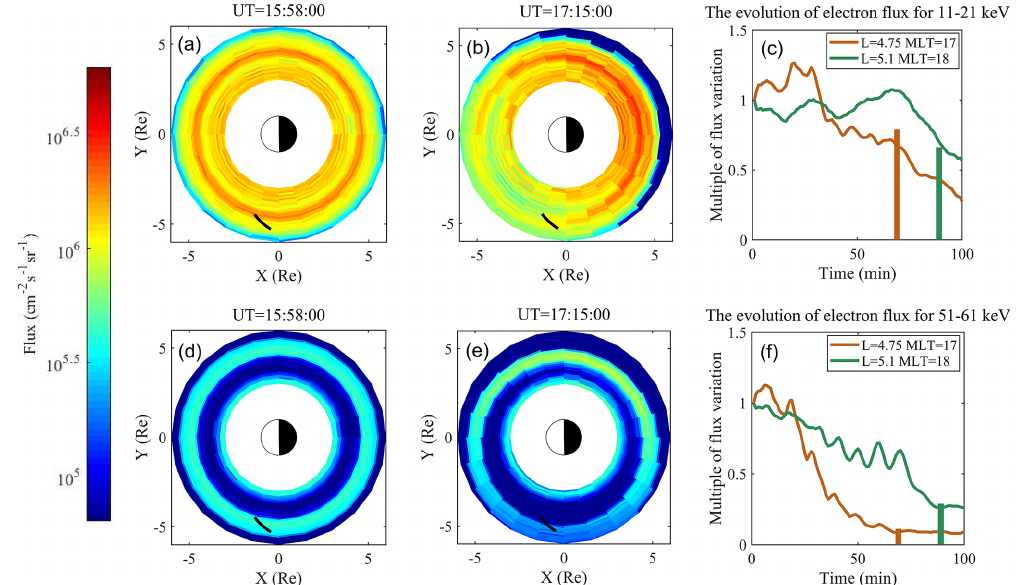
Figure 4. The comparison between the observed and simulated electron flux. (a) The simulation of electron flux distribution with energies from 11 to 21keV at 15:58UT. The trajectory of the Van Allen Probes is indicated by the solid black curve. (b) The evolved electron distribution with initial energies from 11 to 21keV at 17:15UT. (c) The normalized variations of electron fluxes with the energies from 11 to 21keV as a function of time after 15:58UT at L ∼ 4.75 ( L ∼ 5.1) are indicated by the brown (green) curves. The vertical bars indicate the detected normalized variation of electron fluxes at the corresponding times when Van Allen Probe B passed through L ∼ 4.75 ( L ∼ 5.1). (d–f) The same as (a–d) but for the electrons with the initial energies from 51 to